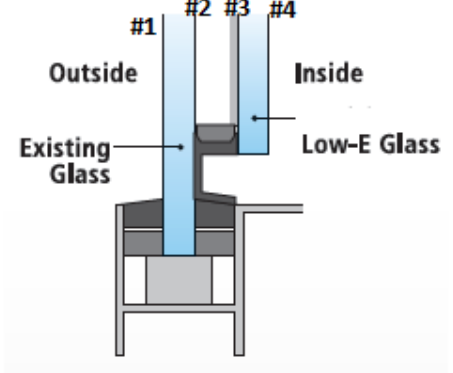
Figure 1. Typical installation of retrofit double glazing .